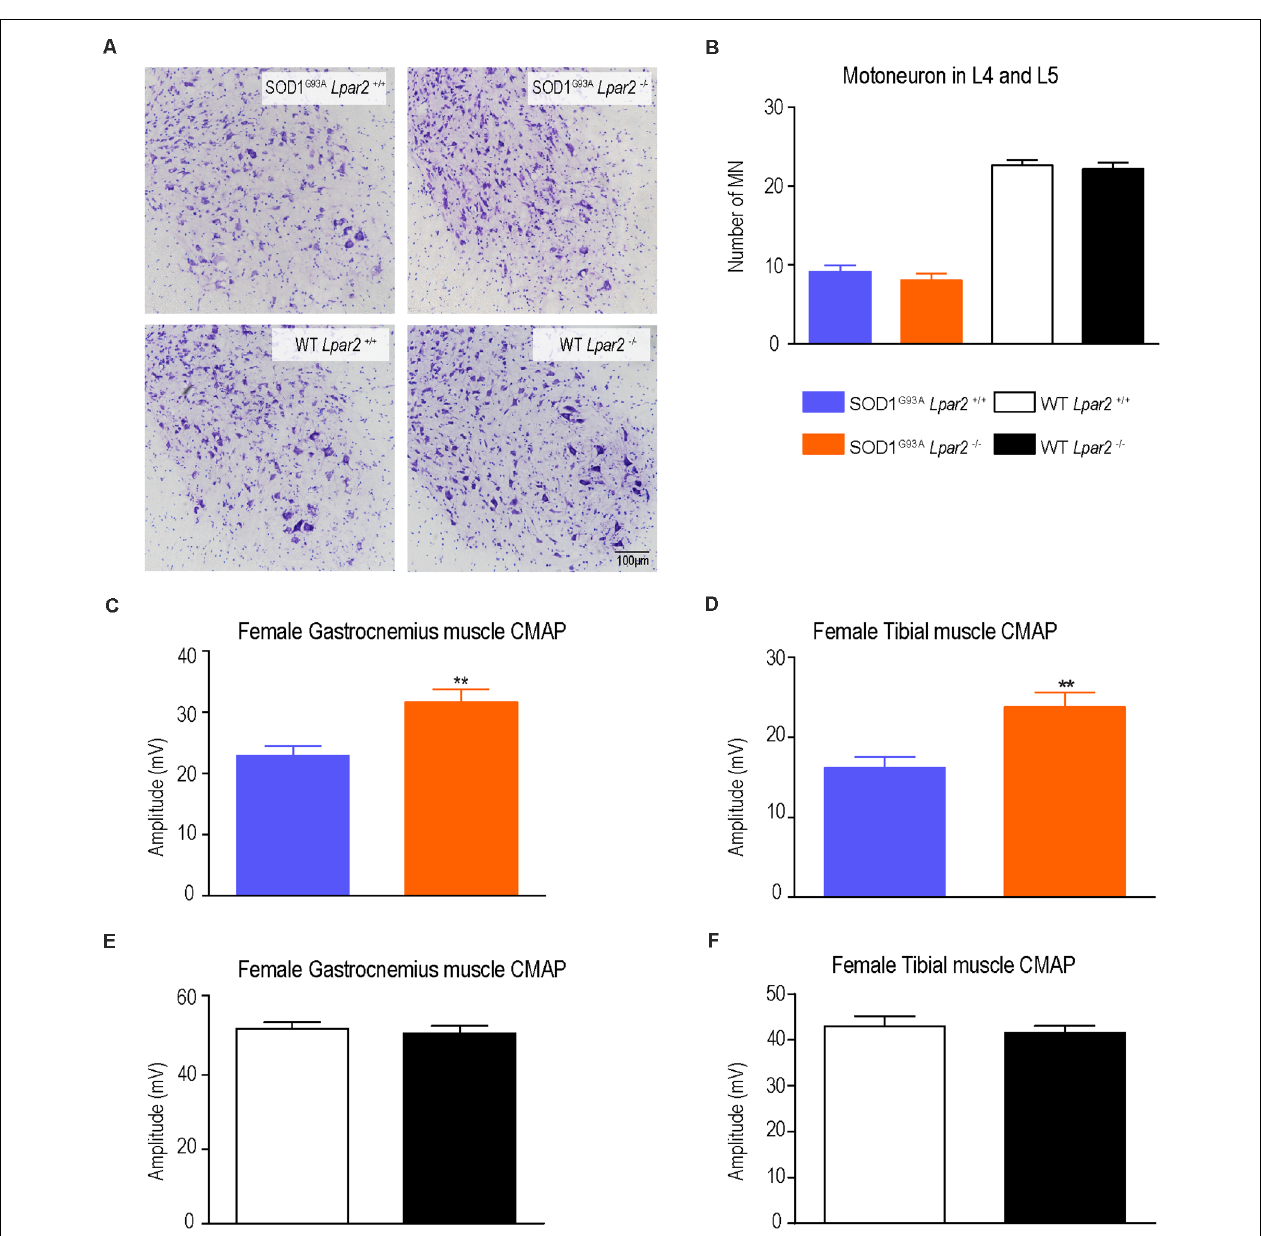
FIGURE 5 | The lack of Lpar2 does not increase motoneuron survival but preserves neuromuscular integrity in ALS mice at 16 weeks of age. (A) Representative micrograph of lumbar spinal cord showing motoneurons stained with cresyl violet. (B) Quantification of motoneurons in the L4 and L5 spinal cord segments (males; n = 6 SOD1 G93A Lpar2 +/+ , n = 9 SOD1 G93A Lpar2 − / − , n = 7 WT Lpar2 +/+ , n = 8 WT Lpar2 − / − ). (C,D) Plots showing the compound muscle potential amplitude of the gastrocnemius (C,E) and tibialis anterior (D,F) muscle at 16 weeks of age (males; n = 14 SOD1 G93A Lpar2 +/+ , n = 14 SOD1 G93A Lpar2 − / − , n = 5 WT Lpar2 +/+ , n = 5 WT Lpar2 − / − ). ** p < 0.01 vs. SOD1 G93A LPA 2+/+ . One-way ANOVA, Bonferroni’s post hoc test. Data are shown as mean ±